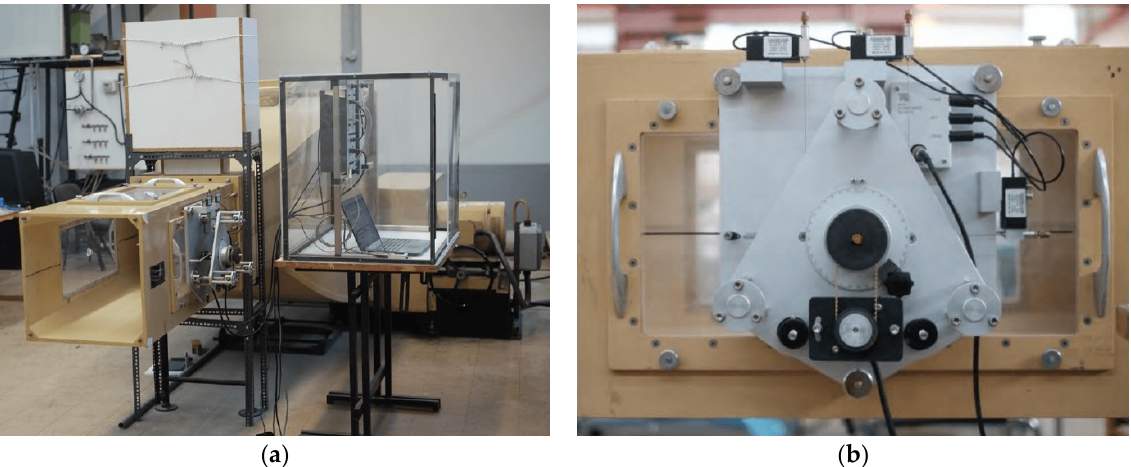
Figure 5. ( a ) Subsonic wind tunnel at Fluid Mechanics Laboratory, University of Patras; ( b ) three- component AFA3 aerodynamic balance at Fluid Mechanics Laboratory, University of Patras.